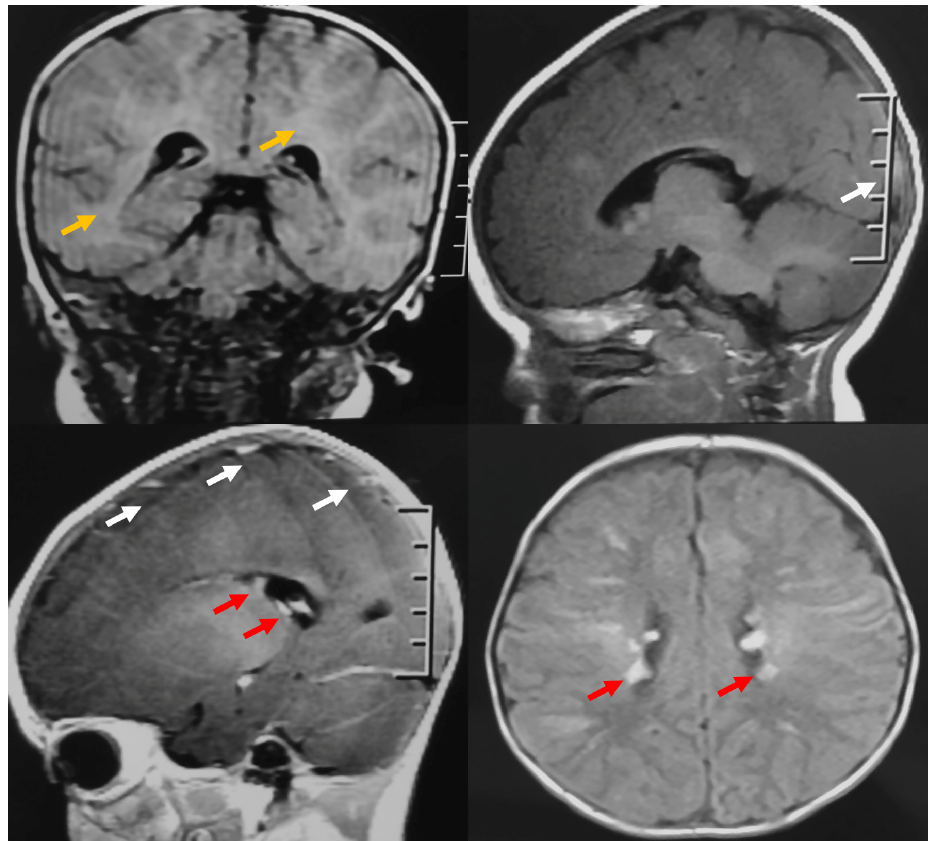
Figure 2: Cerebral MRI revealing diffuse areas of commitment in the white matter (yellow arrow) and cortex with multiple frontal, temporal, parietal, and occipital (white arrow), subependymal lesions of tubers (red